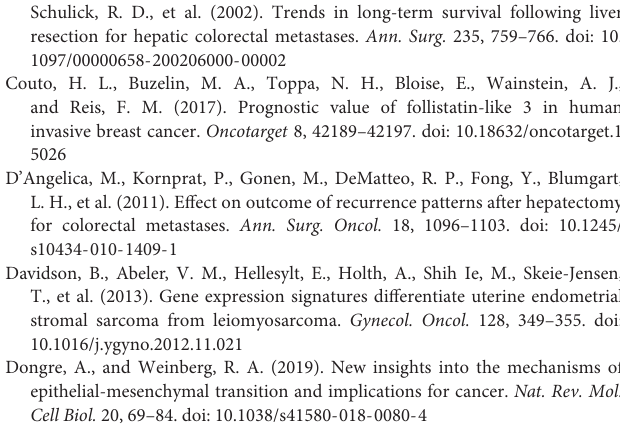
Supplementary Figure 1 | Vector information and partial promoter sequence of human FSTL3 gene (NM_005860), showing three potential YAP1 binding sites ( boxes ). Supplementary Figure 2 | The data from various databases identified increased FSTL3 expression as a poor prognostic factor in CRC. Supplementary Figure 3 | Analysis in GEPIA database (http://gepia.cancer-pku.cn/) illustrated that expression of FSTL3 is obviously related to EMT-connected proteins, including CDH1, CDH2, FN1, and VIM in CRC tissues. Supplementary Figure 4 | Analysis in GEPIA database (http://gepia.cancer-pku.cn/) illustrated that β -Catenin expression is significantly associated with proteins related to aerobic glycolysis, including SLC2A1, LDHA, HK2, and PKM. Supplementary Figure 5 | Analysis in GEPIA database (http://gepia.cancer-pku.cn/) illustrated that FSTL3 expression is positively associated with expression of SLC2A1, LDHA and PKM, but negatively related to HK2. Supplementary Table 1 | The primary antibodies used in this study. Supplementary Table 2 | Primer